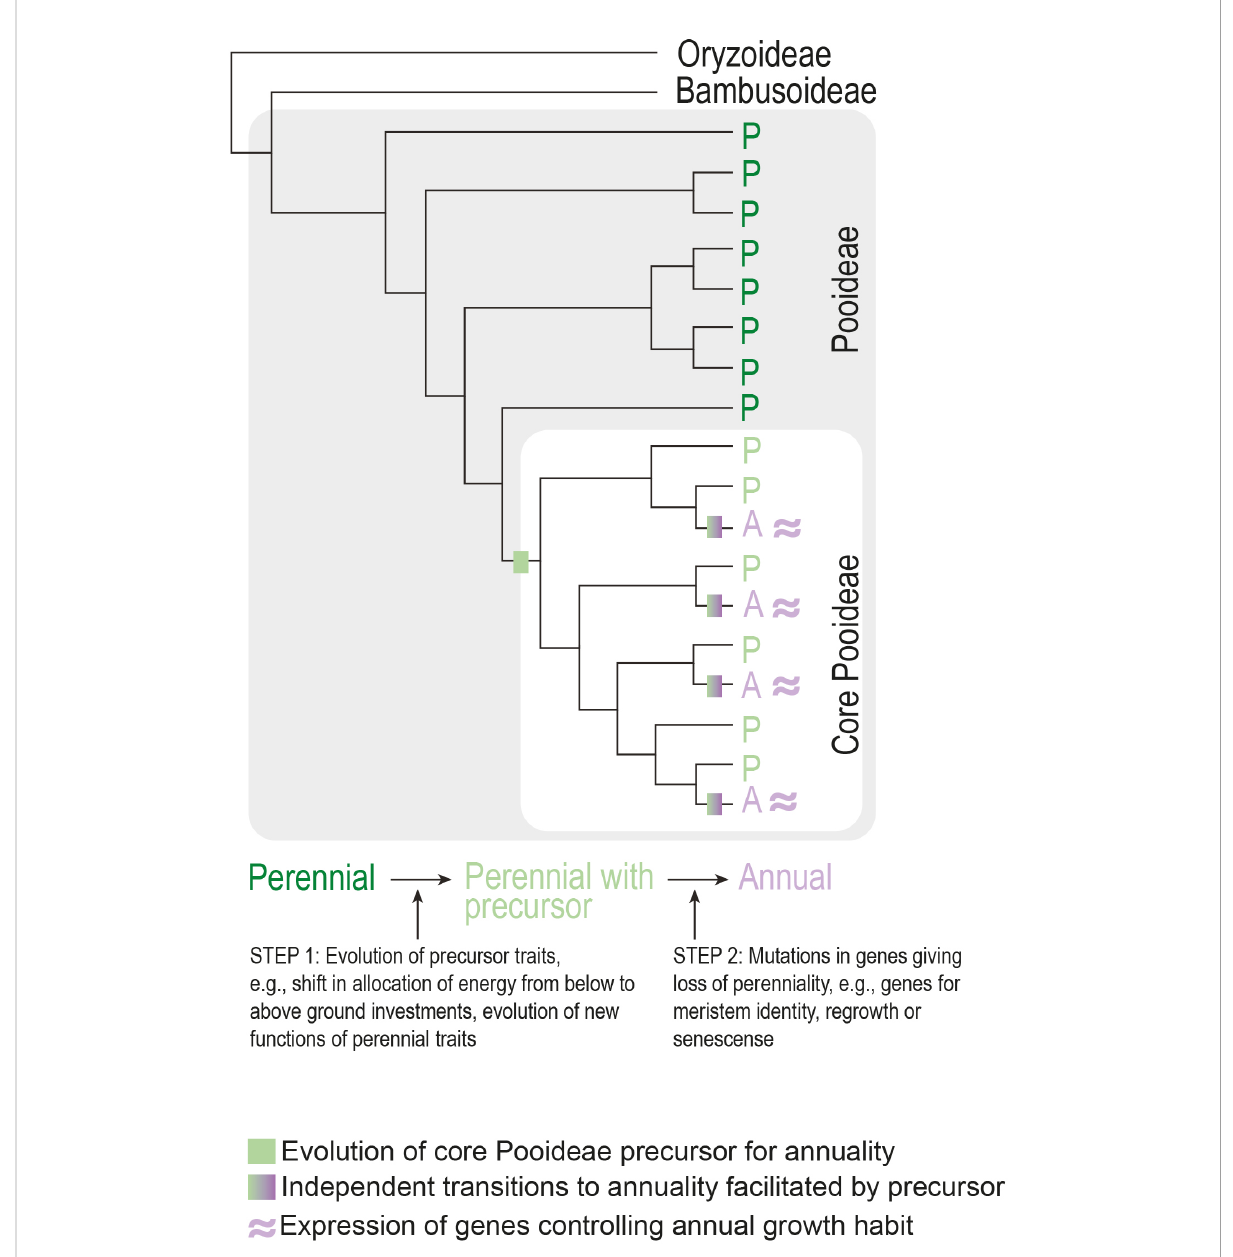
FIGURE 6 Model for the evolution of annuality in the Pooideae subfamily of grasses. Assuming the precursor represents a common genetic basis, transition to annuality occurs through parallel evolution involving the same